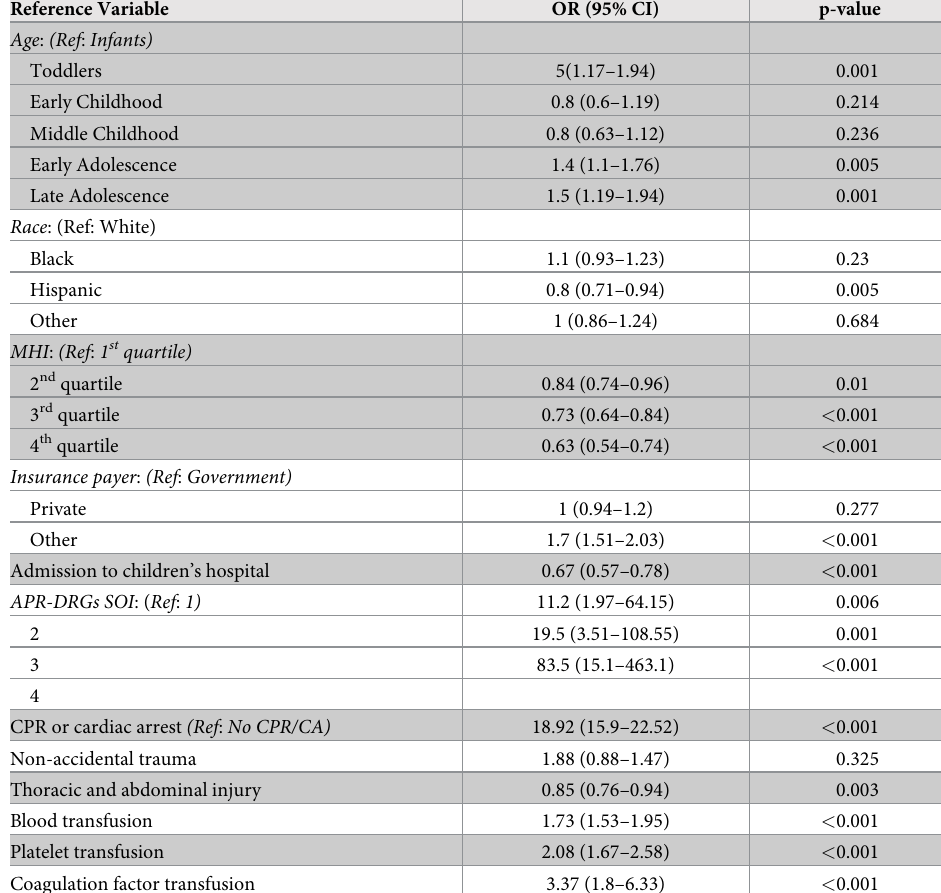
Table 4. Logistic regression analysis showing variables affecting mortality in children with traumatic brain injury who received mechanical ventilation. Reference